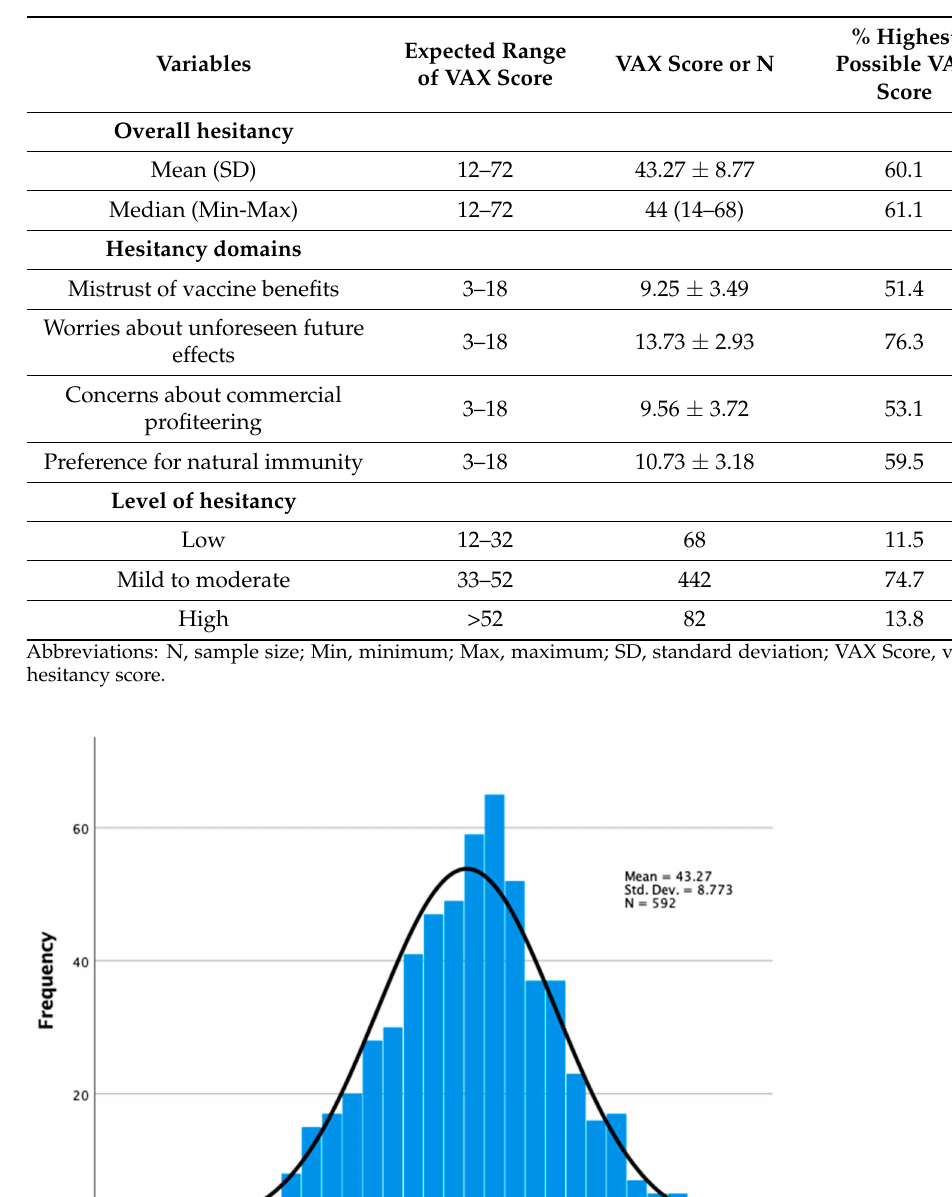
Table 3. Domain and Overall Vaccine Hesitancy Scores.